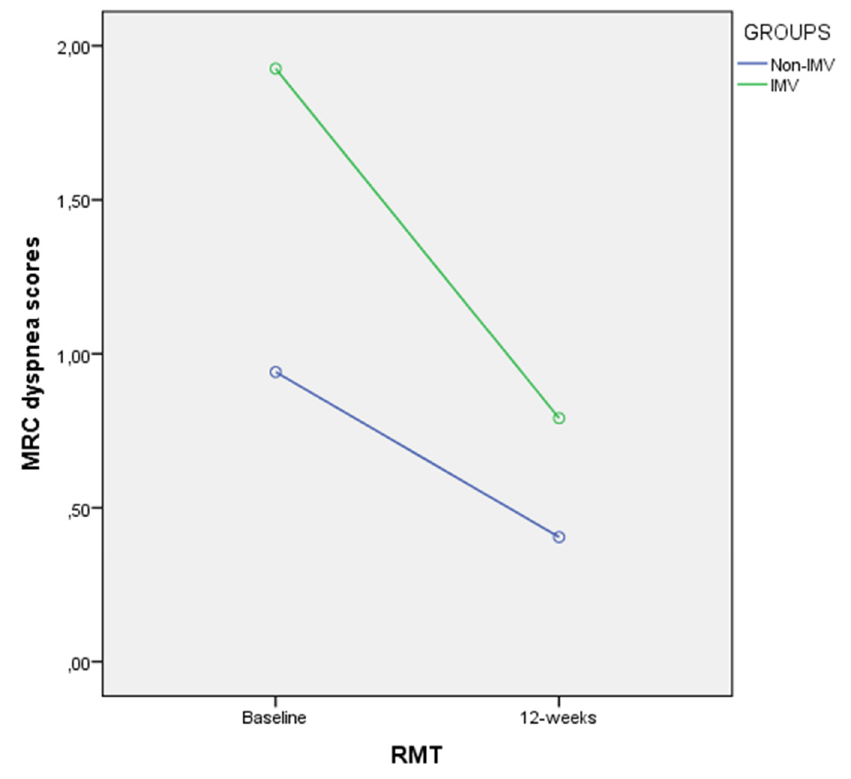
Figure 1. Linear graph showing the comparison of outcome measurement differences after RMT between non-IMV and IMV groups. Abbreviations: IMV, invasive mechanical ventilation; RMT, respiratory muscle training; MRC, Medical Research Council dyspnea scale.